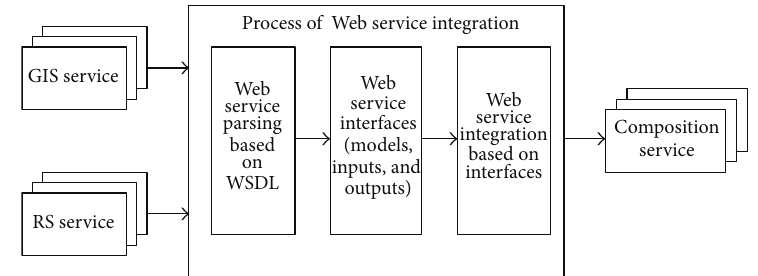
Figure 5: Processes of Web service integration in the model